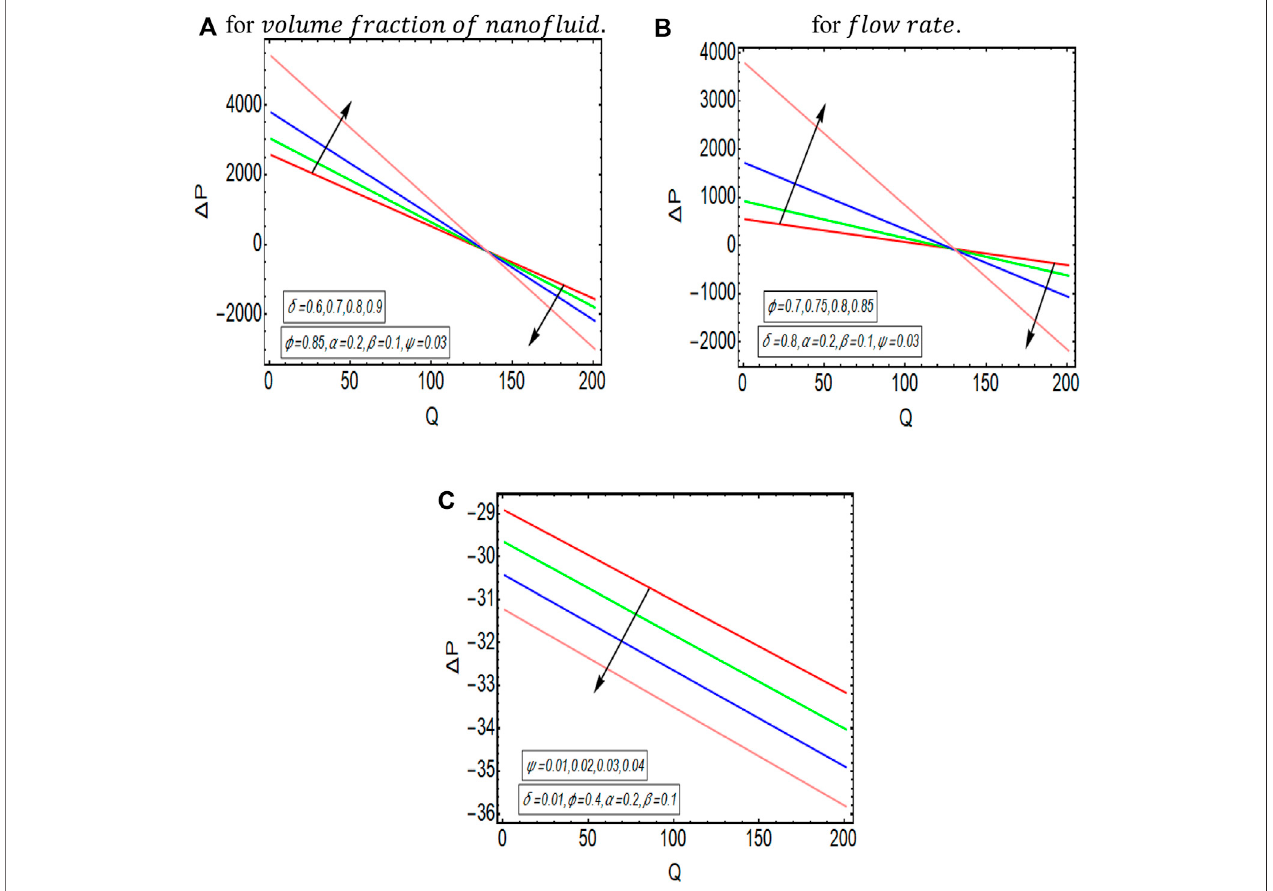
FIGURE 12 | (A) Δ P against flowrate for aspectratio . (B) Δ P against flowrate for occulsion . (C) Δ P against flowrate for volumefractionof nanofluid .